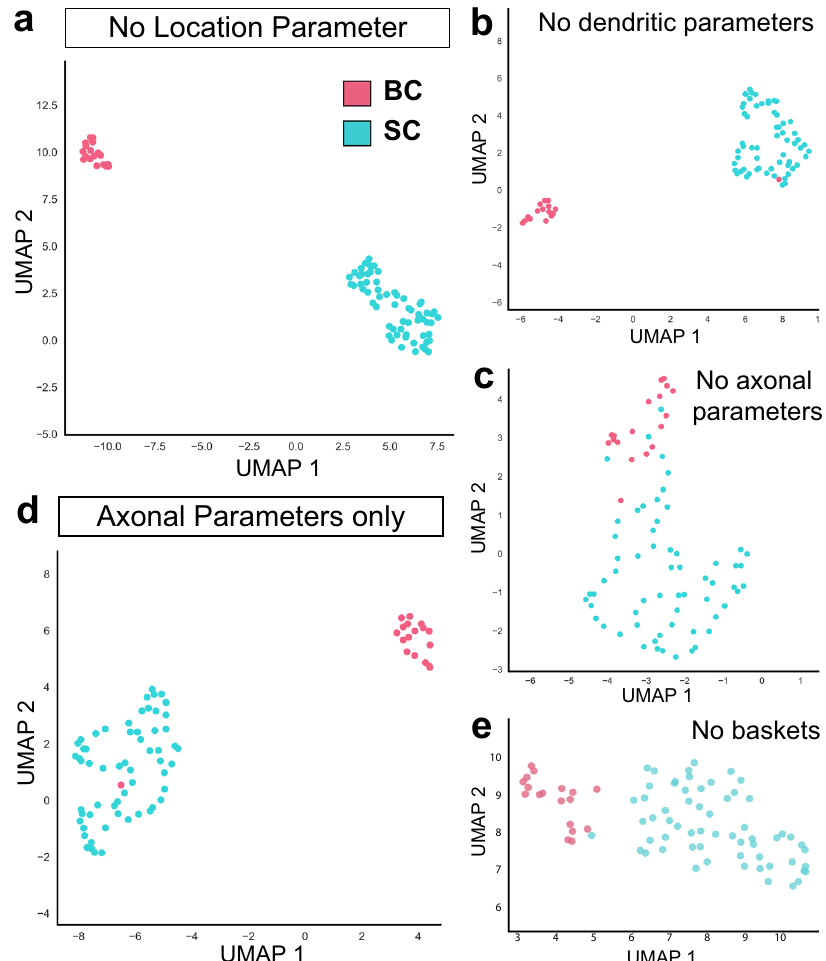
Fig. 3 Axonal information is necessary and suf fi cient for MLI morphological subtyping. a UMAP plots of BC (pink) and SC (cyan) clusters following recursive elimination of morphometric parameters describing MLI location. b UMAP following elimination of dendritic parameters. c UMAP following elimination of axonal parameters. d UMAP with only six axonal parameters is suf fi cient for BC/SC clustering. e UMAP following elimination of PC soma terminal/weighted basket